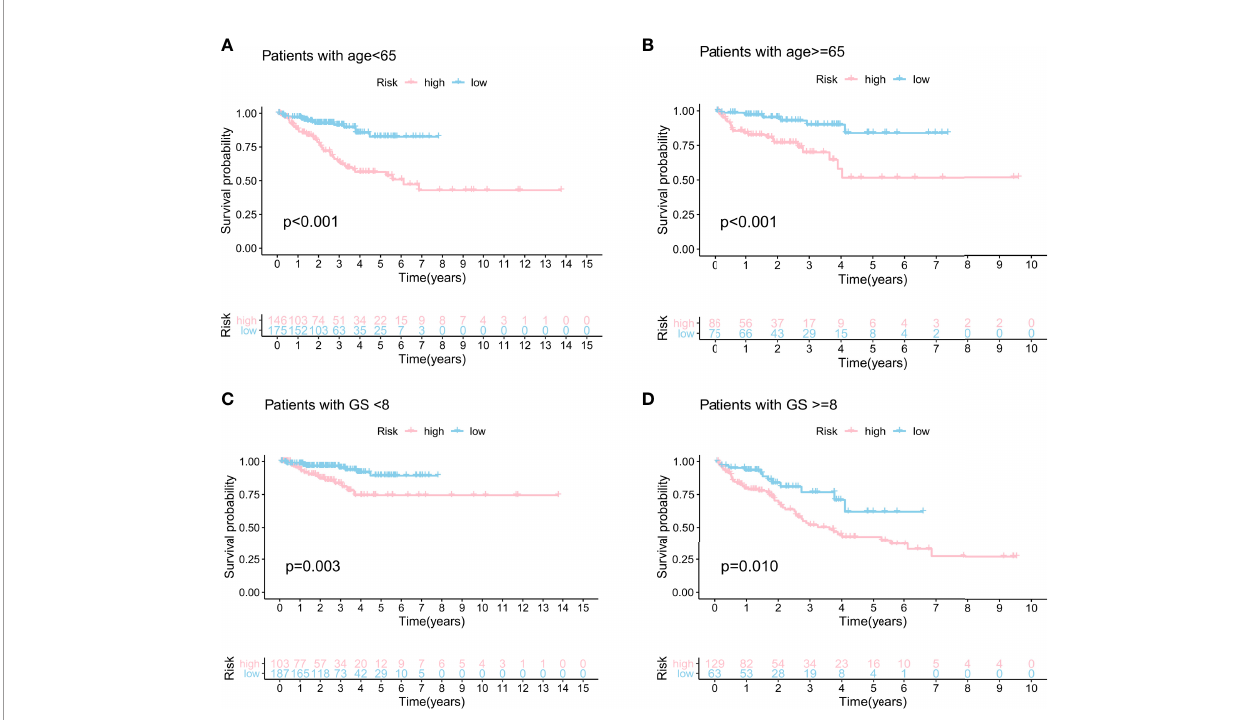
FIGURE 5 | Strati fi cation analyses by age and Gleason score. Kaplan – Meier curve analysis of biochemical recurrence in the high- and low-risk groups for patients <65 years of age (A) and patients ≥ 65 years of age (B) . Kaplan – Meier curve analysis of biochemical recurrence in the high- and low-risk groups for patients with GS <8 (C) and patients with GS ≥ 8 (D)